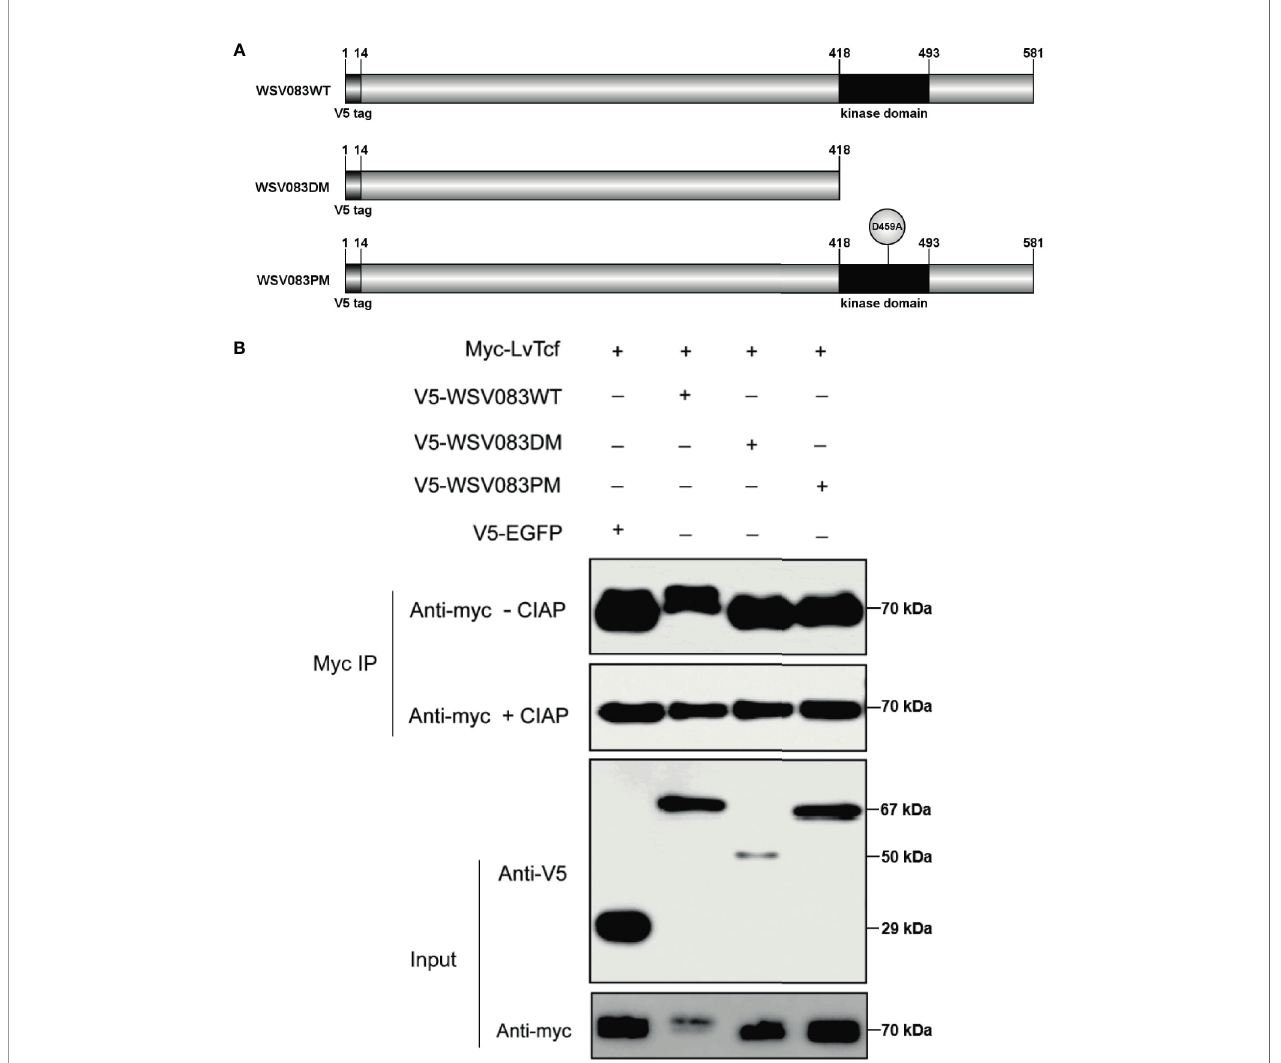
FIGURE 4 | LvTcf phosphorylation by WSV083. (A) Schematic diagram of WSV083 and its kinase activity de fi ciency mutant expression vectors. (B) High Five cells were co-transfected with Myc-LvTcf and V5-EGFP, V5-WSV083WT, V5-WSV083DM, V5-WSV083PM, respectively. After 48 h, whole-cell extracts were immunoprecipitated with anti-Myc and protein A beads. Immunoprecipitates were then subjected to CIAP treatment and immunoblotting as